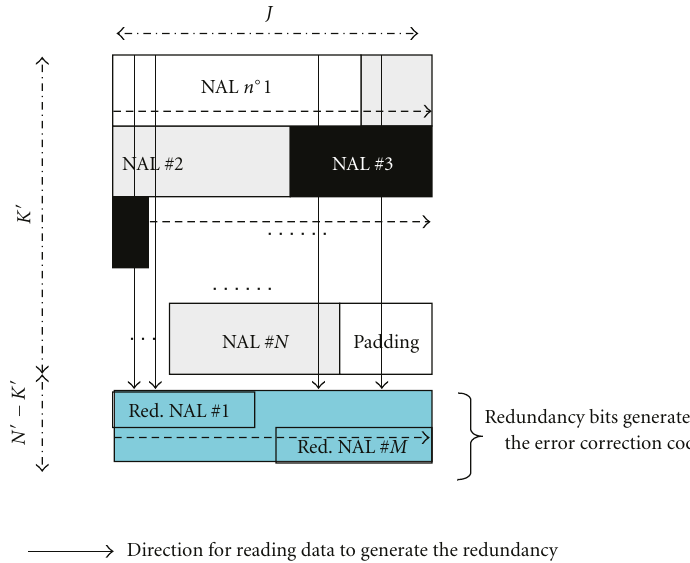
Figure 2: N / M redundancy matrix organisation.